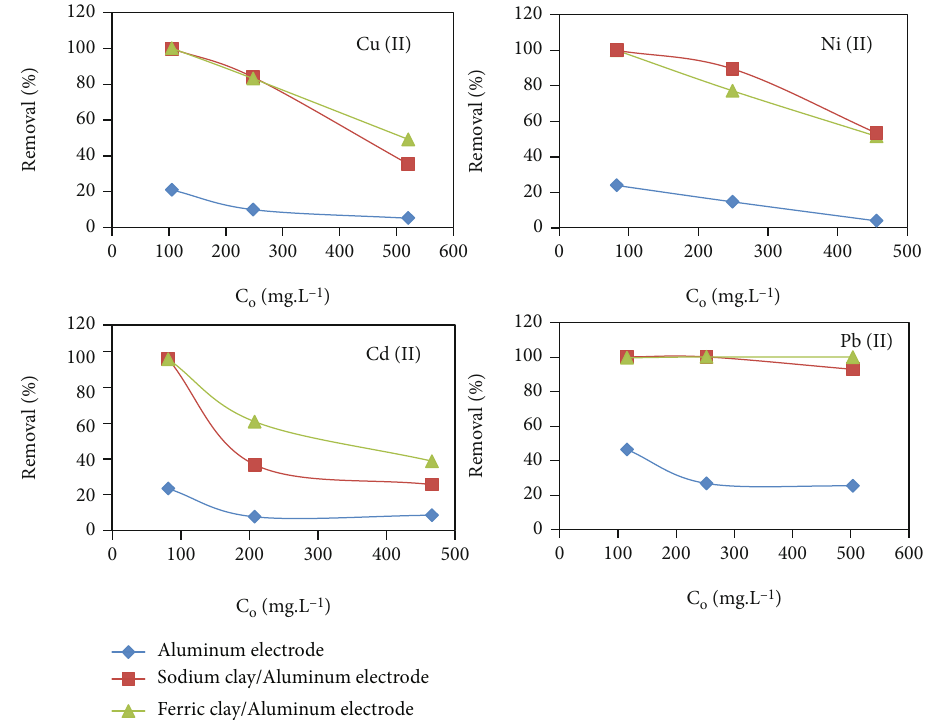
Figure 13: Percentage of removal of Cu(II), Ni(II), Cd(II), and Pb(II) ions in di ff erent systems using aluminum electrode. pH = 5 : 5 , T = 28 ° C